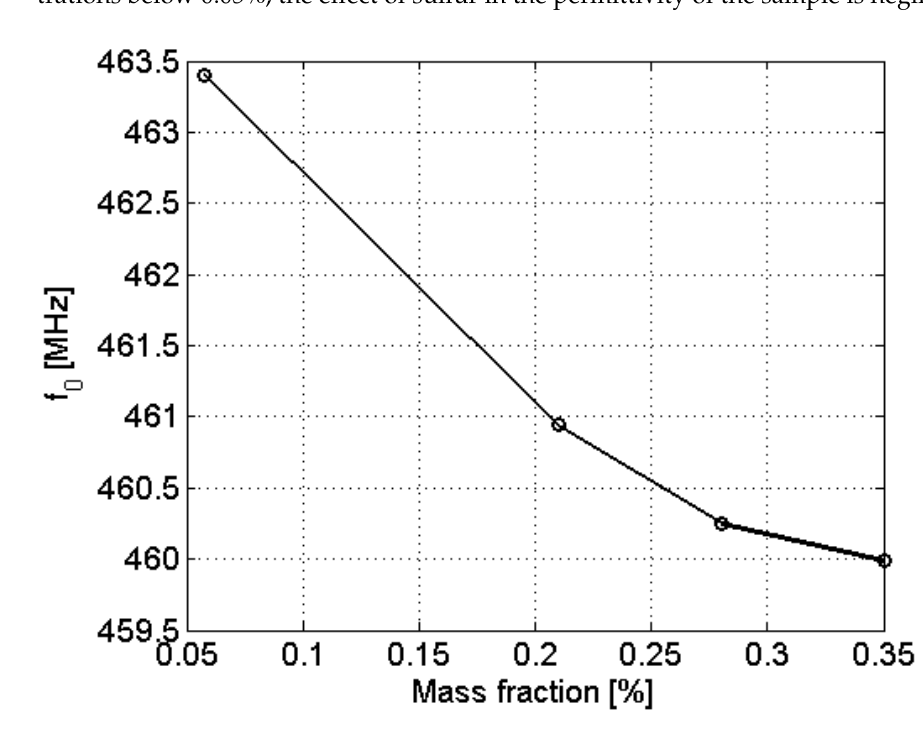
Figure 7. Evolution of the resonant frequency f 0 with the mass fraction of